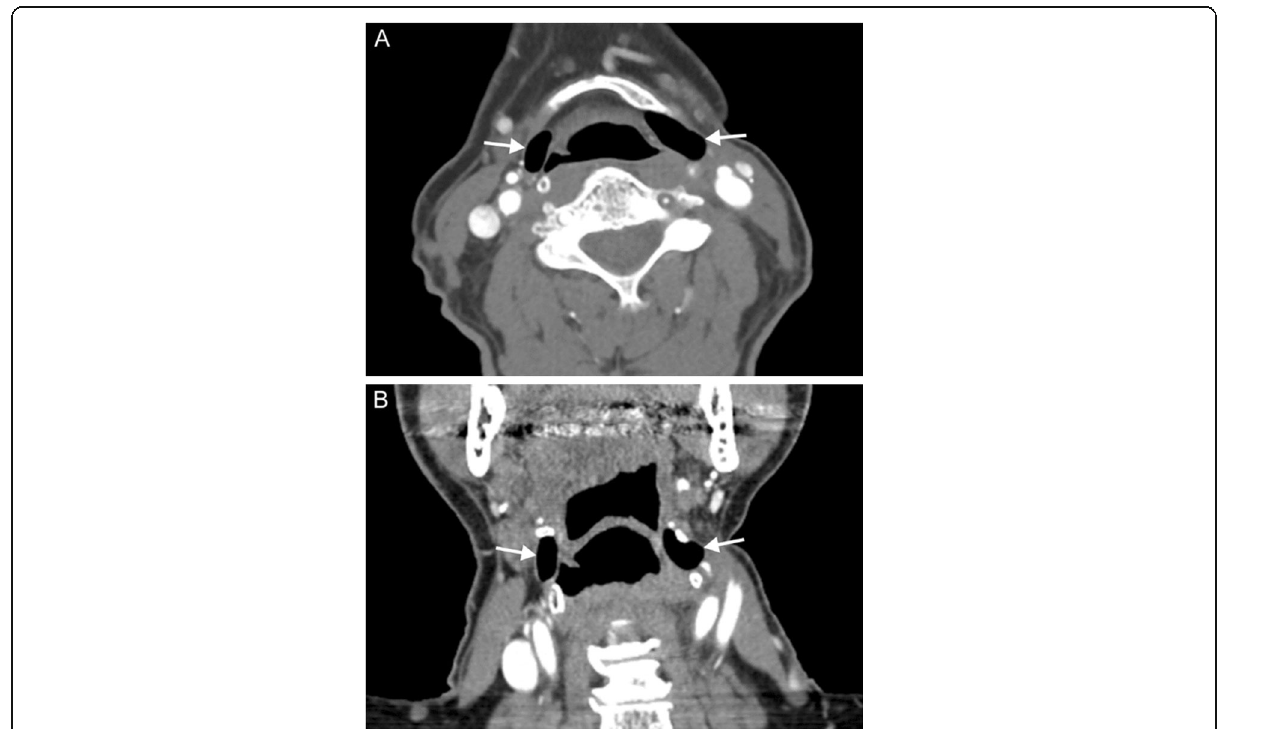
Fig. 4 Laryngocele. A 67-year-old man with history of prior tongue base and oropharyngeal squamous cell carcinoma status post radiation completed 8 years prior presents with dysphagia and hoarse voice. Axial ( a ) and coronal ( b ) contrast-enhanced CT images demonstrate bilateral supraglottic laryngoceles (arrows) with mild extralaryngeal extension on the